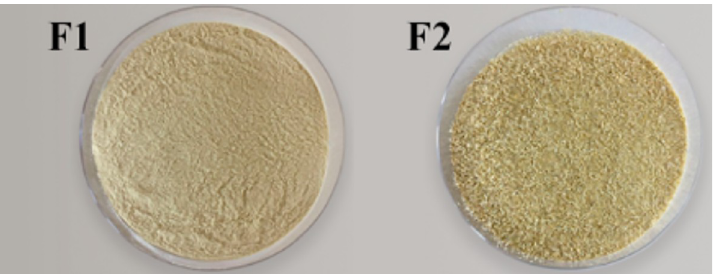
Fig 1. Xiquexique flour. Xiquexique flour tamized at 100 mesh (F1) and xiquexique flour tamized at 28 mesh (F2).